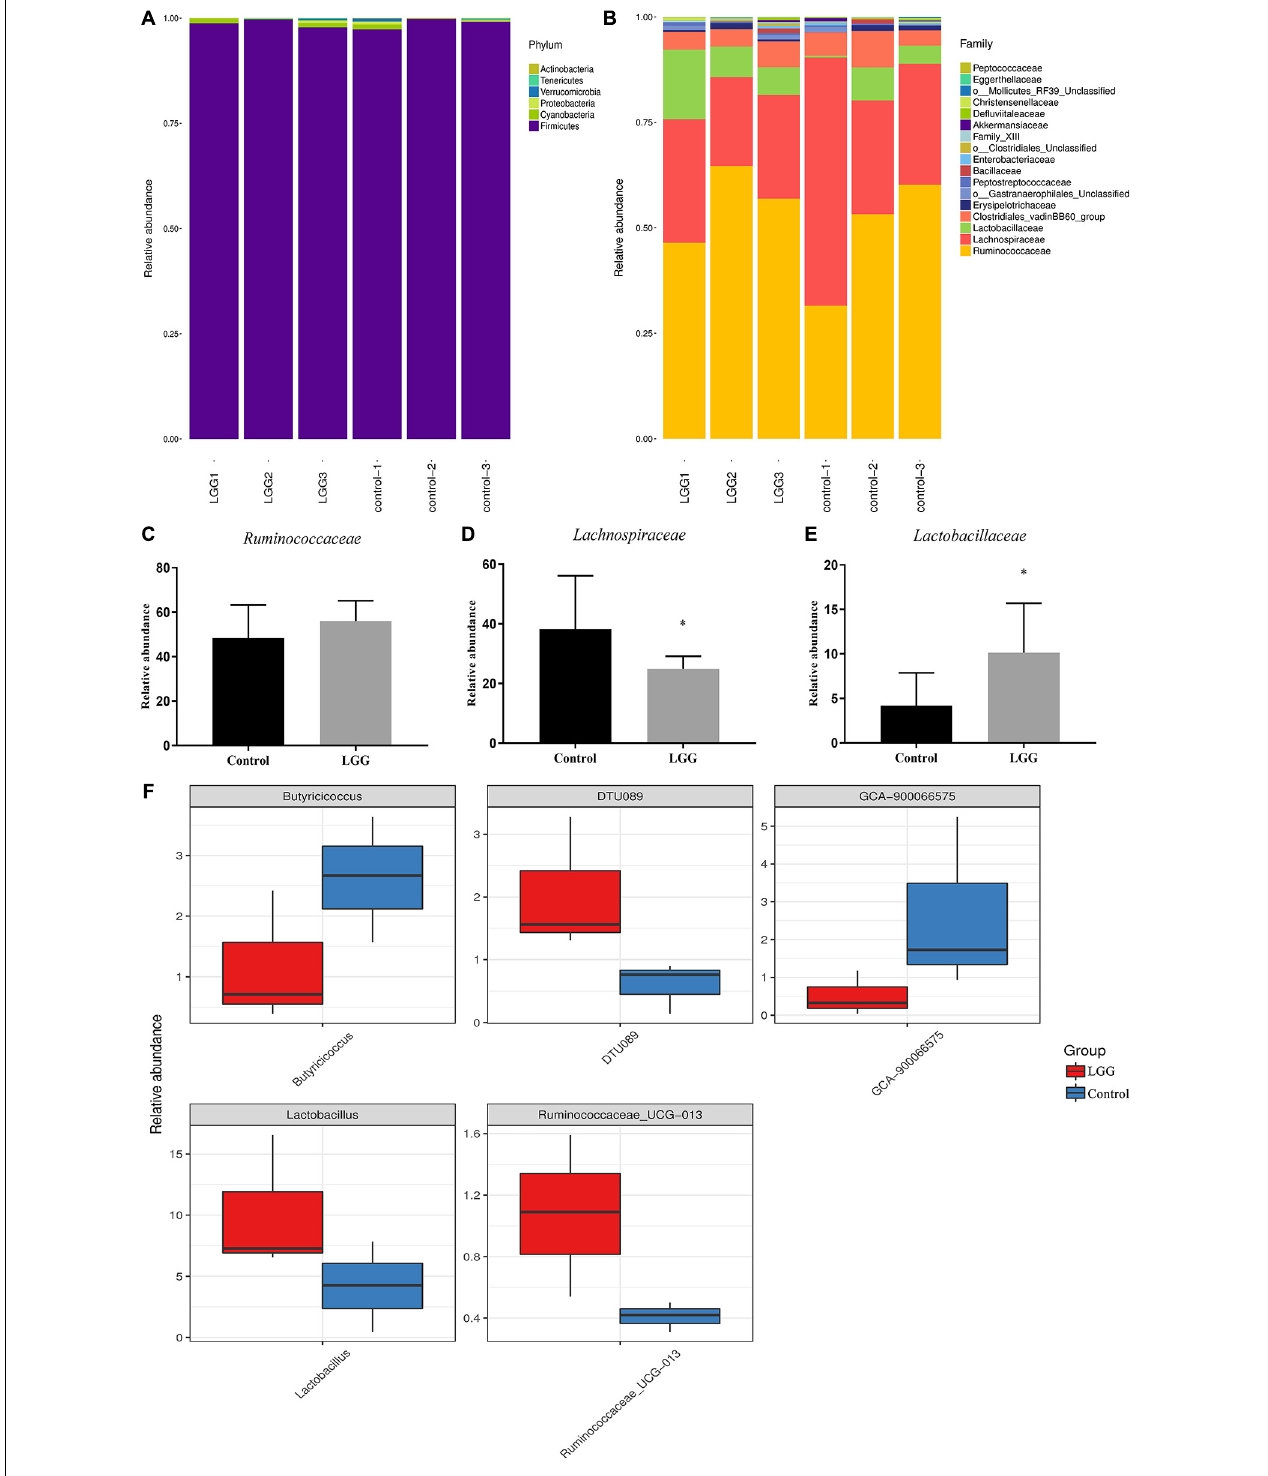
FIGURE 4 | Comparison of identified relative abundance in cecal microbes. Relative abundance of bacterial (A) phylum level and (B) family level. Relative abundance of (C) Ruminococcaceae , (D) Lachnospiraceae , and (E) Lactobacillaceae . Bars represent the means ± standard deviations of three independent repetitions. * p < 0.05. (F) The differential abundance between LGG and the control group based on metastats difference analysis. The abundance distribution of the five species with the greatest difference between the two groups was presented.